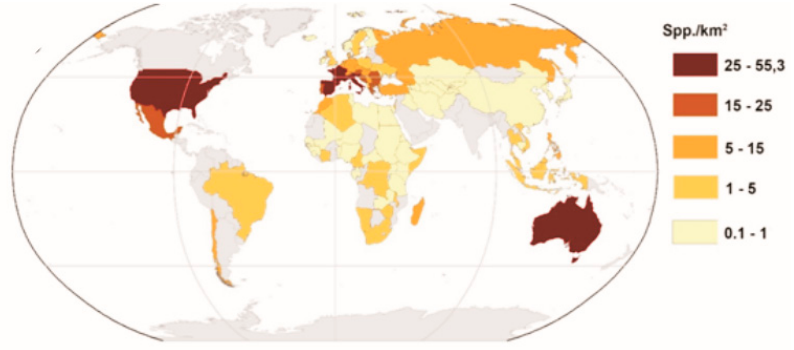
Figure 7. Distribution of obligate subterranean species by country, corrected for area. See Zagmajster et al. [62] for details. With permission of Springer Nature.